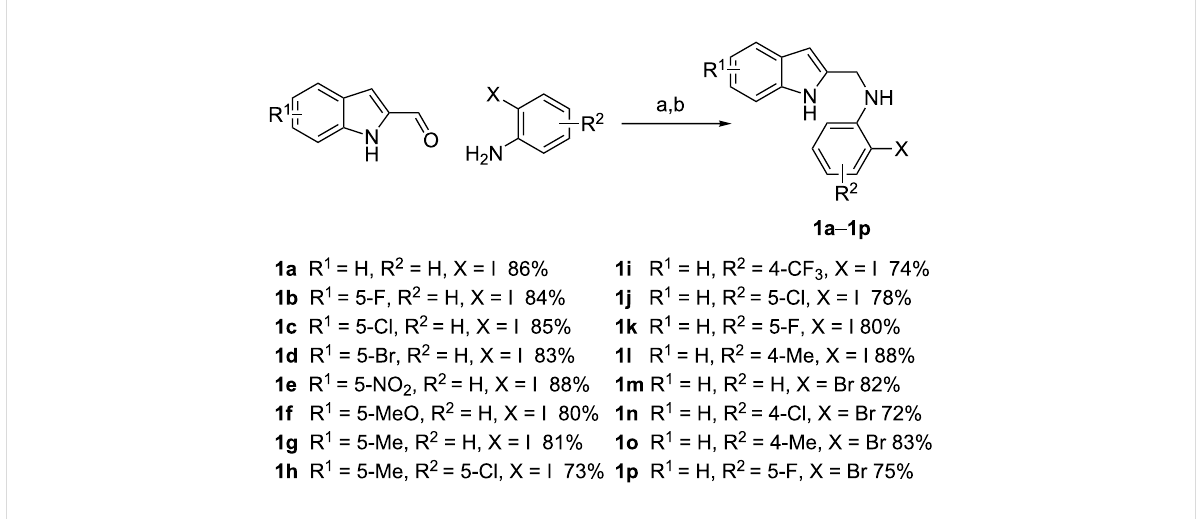
especially for the arylation of N-containing heterocycles such as indoles, imidazoles, indazoles, pyrroles, pyrazoles and triazoles [25-28] to construct more fused